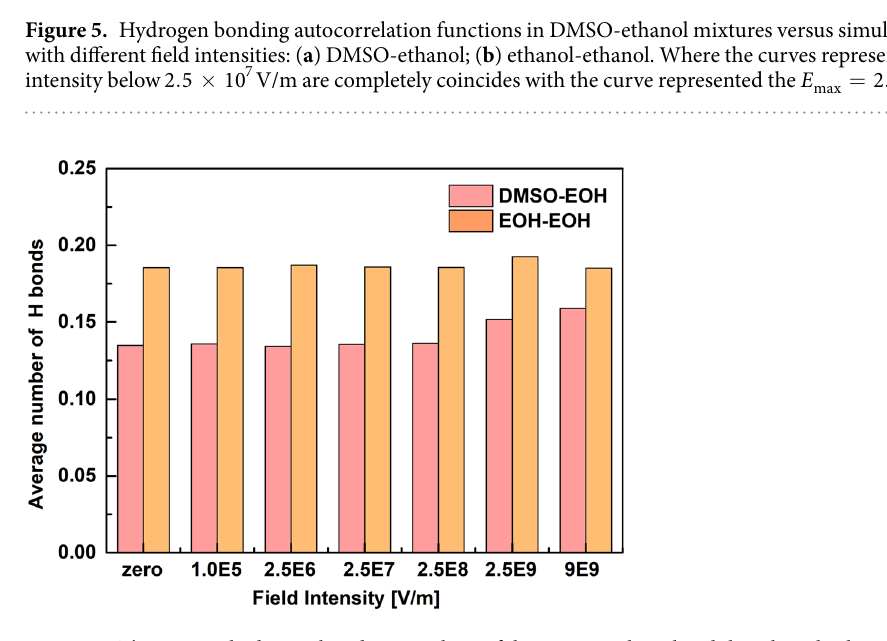
Figure 6. The average hydrogen bonding numbers of the DMSO-ethanol and the ethanol-ethanol as the function of field